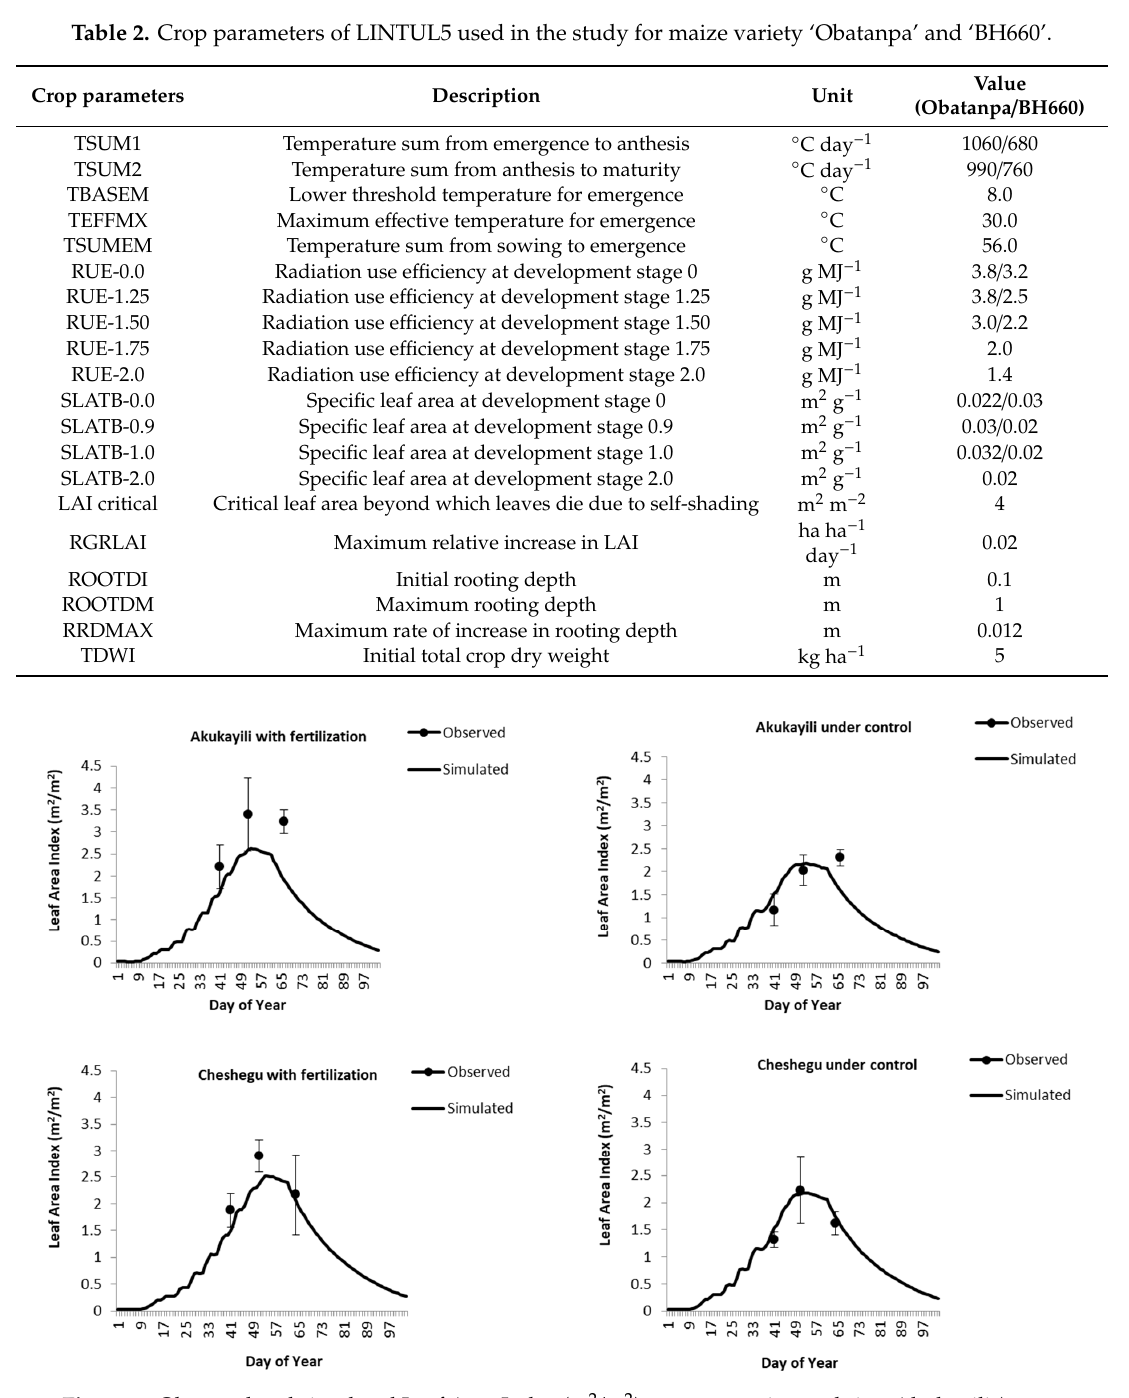
Figure 2. Observed and simulated maize yield (variety BH660) in (Mg/ha ) at two experimental sites, Bako ( a ) and Jimma ( b ), in Ethiopia under fertilized conditions.